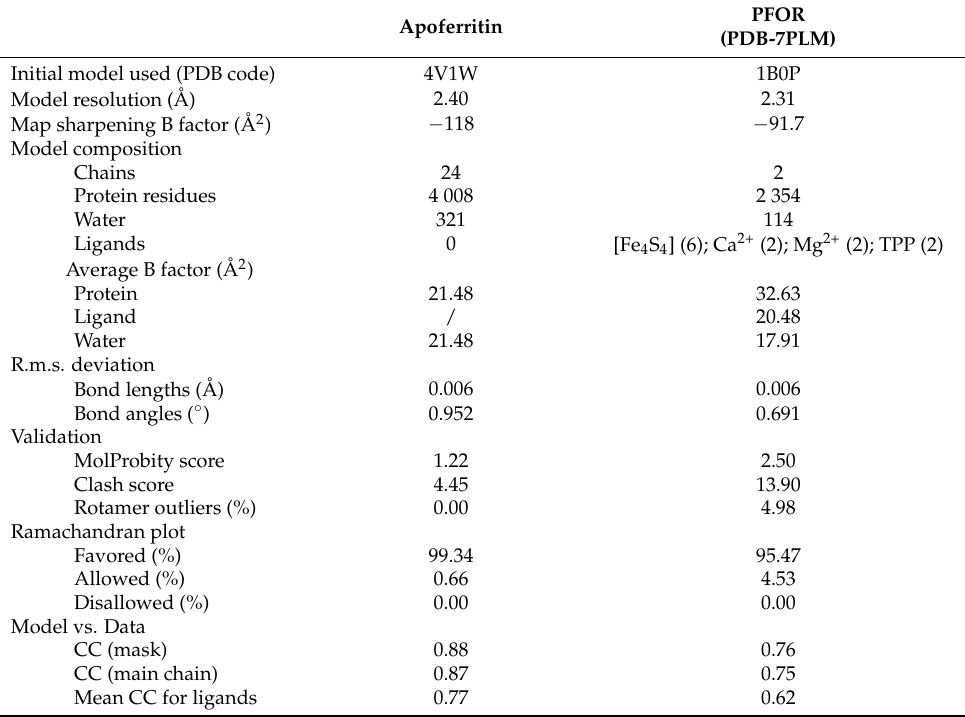
Table 2. Cryo-EM refinement and validation